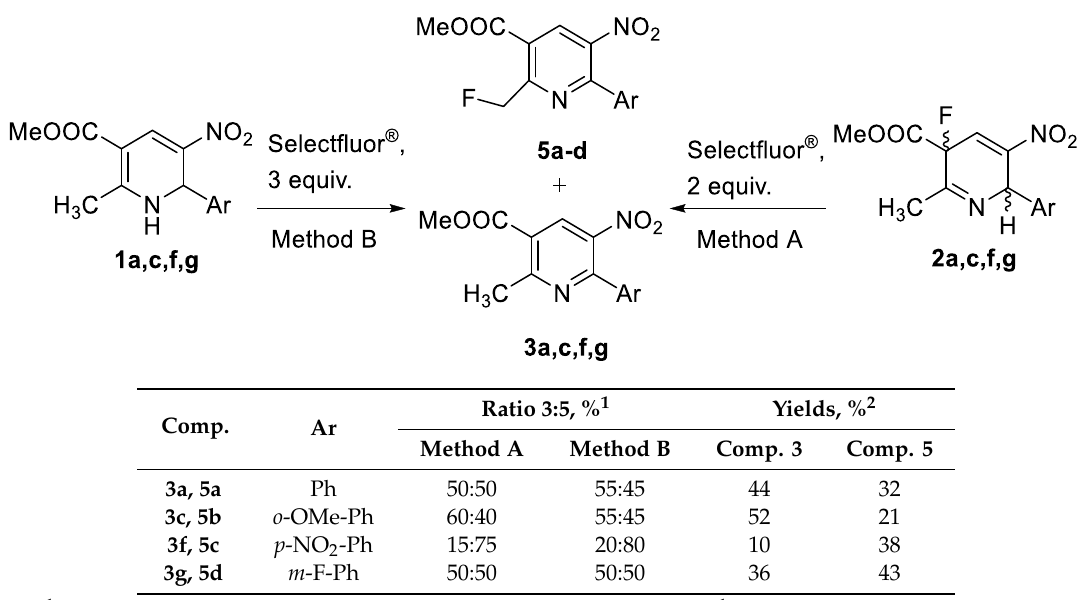
Table 5. Reactions of 3-fluoro-2-methyl-5-nitro-3,6-dihydropyridines 2a,c,f,g or 1,2-dihydropyridines 1a,c,f,g with Selectfluor ® , leading to the formation of a mixture of methyl 2-(fluoromethyl)-5-nitro-6-arylnicotinates 5a – d and 2-methylpyridines 3a,c,f,g .